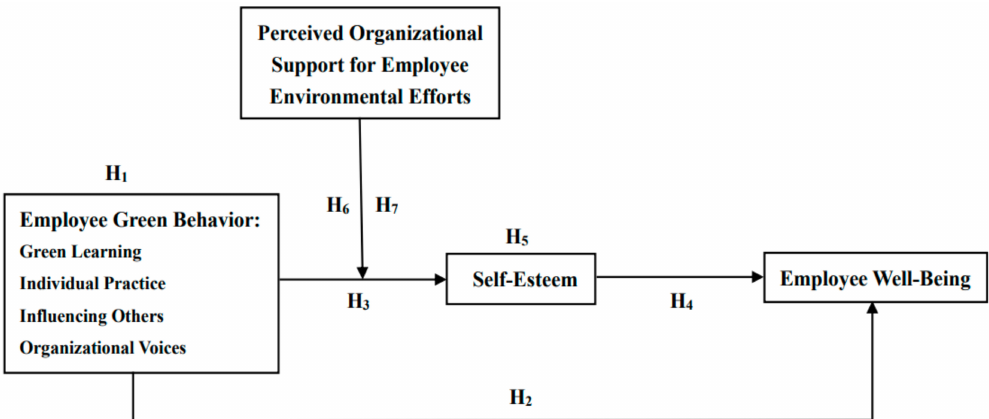
Figure 1. The hypothesized